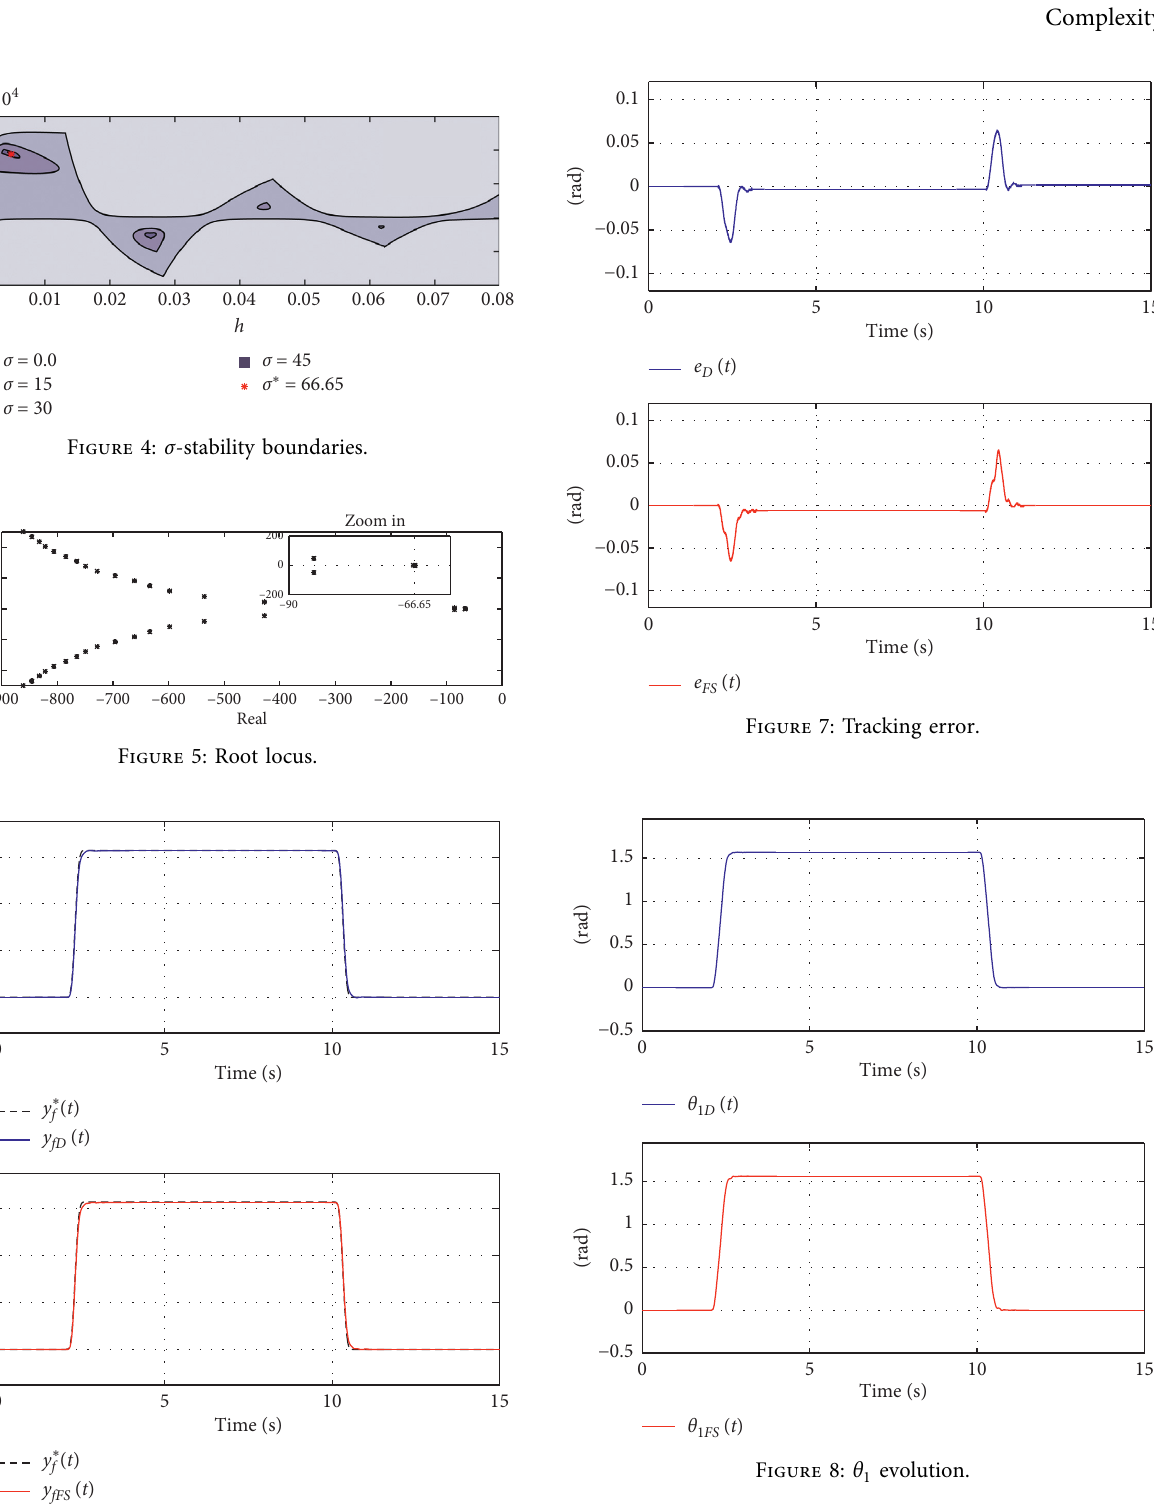
Figure 6: Trajectory tracking results.